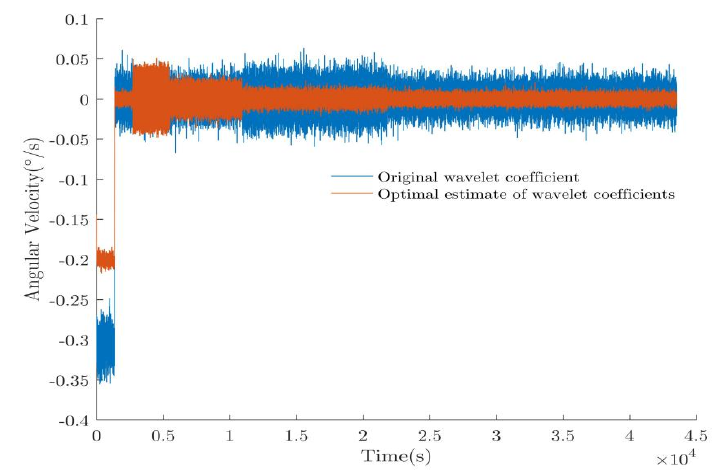
Figure 9. Comparison of the original wavelet coefficients and the optimal estimate of the wavelet coefficients.